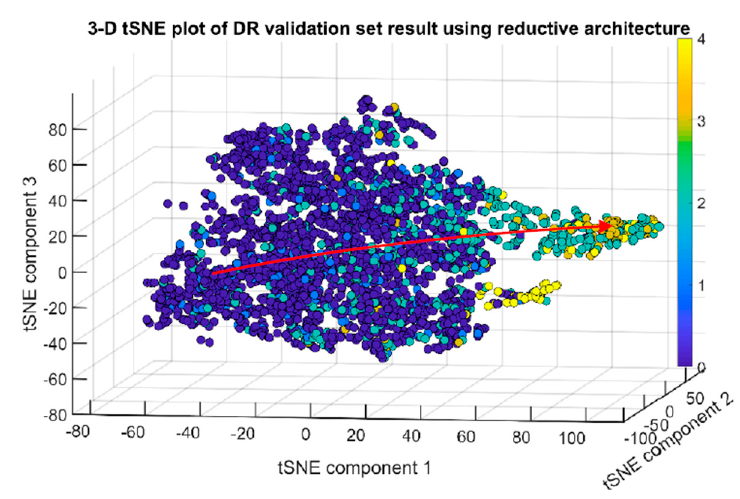
Figure 6. Reconstruction of disease progression in diabetic retinopathy by CNN with reductive first convolutional layer that was trained on high resolution images. The red arrow indicates the inferred disease progression sequence among dots representing class 0 to 4.